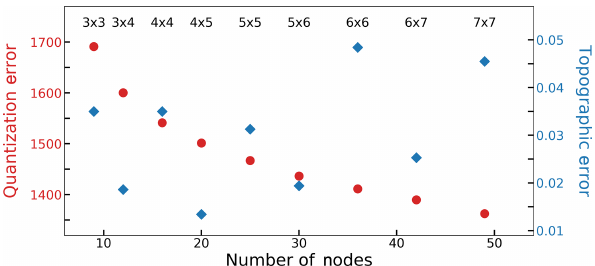
Figure 2. The quantization (red circles; left axis) and topographic (blue diamonds; right axis) errors for each SOM configuration tested in this study. SOM node topologies (rows × columns) range from 3 × 3 to 7 × 7; we choose to use a 4 × 5 node